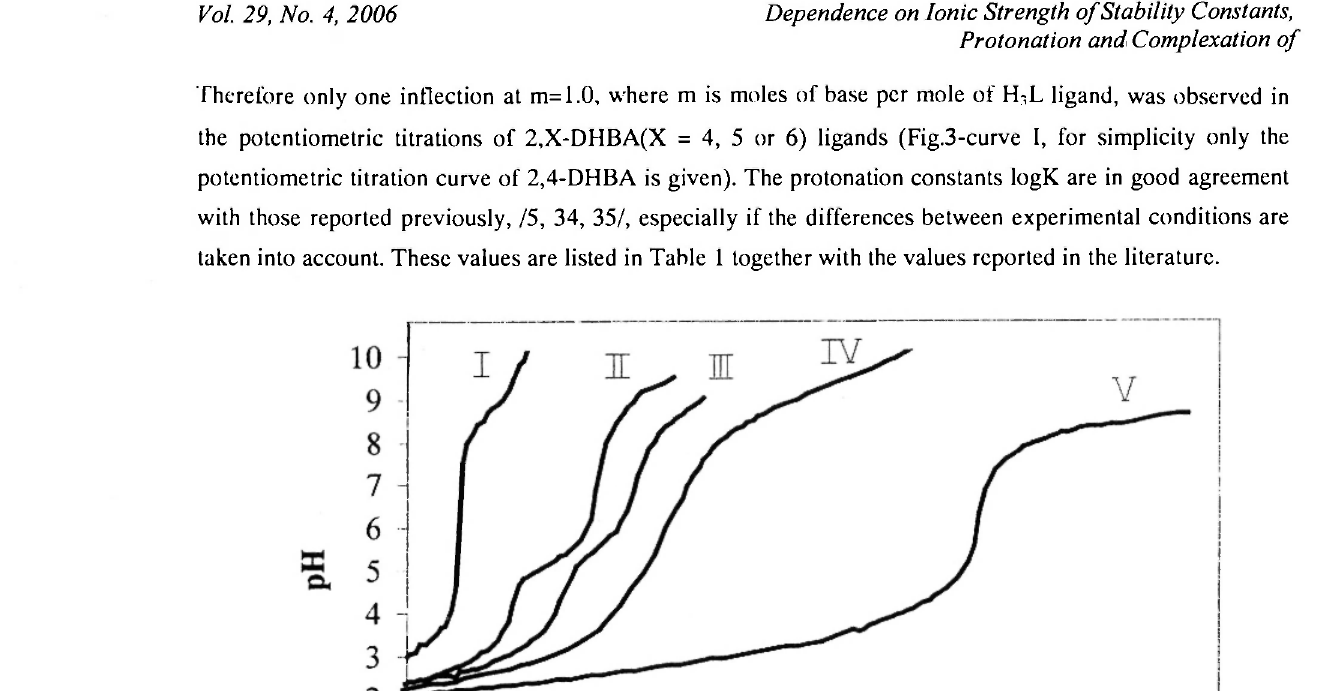
Fig. 3: Potentiometrie titration curves of Al(III) complexes of 2,4-DHBA in 0.1 Μ NaCl at 25°C ± 0.1 °C. I. 2,4-DHBA alone (T L = 9.6x10°